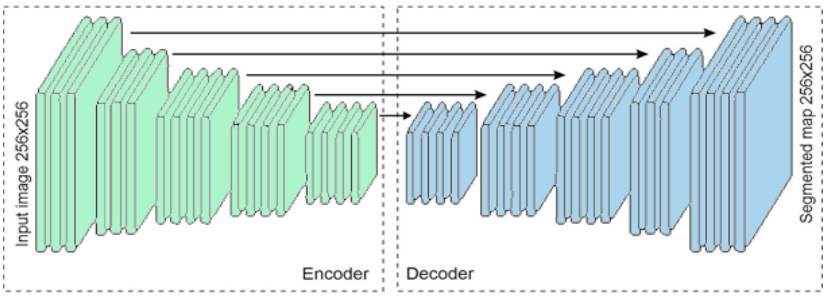
Figure 3. General architecture of neural network model for segmentation.